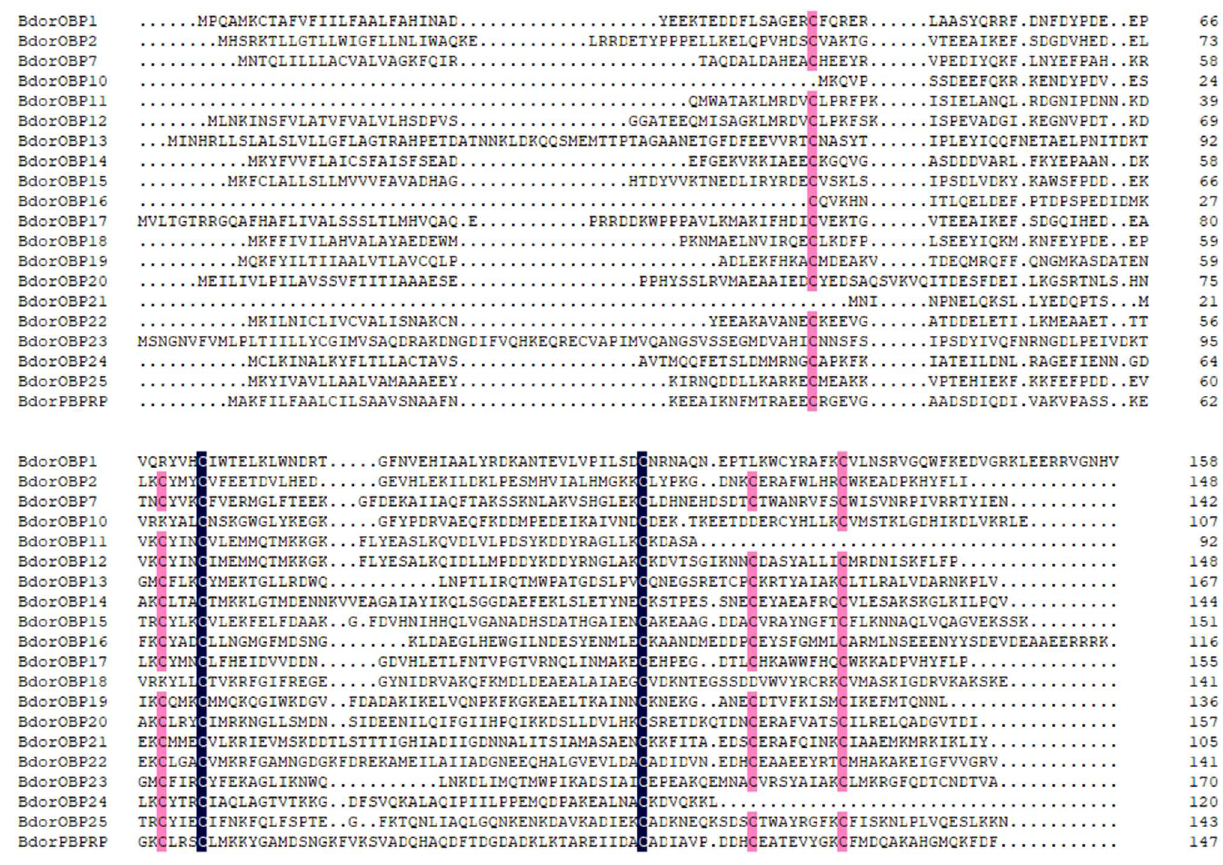
FIGURE 1 | Alignment of deduced amino acid sequences of B. dorsalis OBP members. The alignment was performed with the Clustal X 1.80 tool, and the homologous areas were marked with the Boxshade 3.21